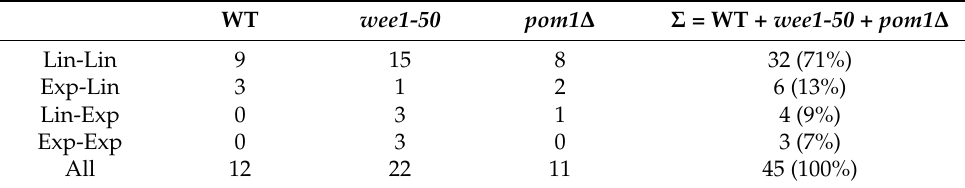
Table 5. Distribution of growth patterns based on both segments of ‘bilinear’ cells. WT wee1-50 pom1 ∆ Σ = WT + wee1-50 + pom1 ∆ Lin-Lin 9 15 8 32 (71%) Exp-Lin 3 1 2 6 (13%) Lin-Exp 0 3 1 4 (9%) Exp-Exp 0 3 0 3 (7%) All 12 22 11 45 (100%) Number of cells with having both growth phases I and II ≥ 40 min, represented separately in each cell culture (wild-type, wee1-50 , pom1 ∆ ). The last column shows the sum of the data from the three cell cultures (number and percentage). Lin-Lin, both growth phases I and II are linear; Exp-Lin, growth phase I is exponential, growth phase II is linear; Lin-Exp, growth phase I is linear, growth phase II is exponential; Exp-Exp, both growth phases I and